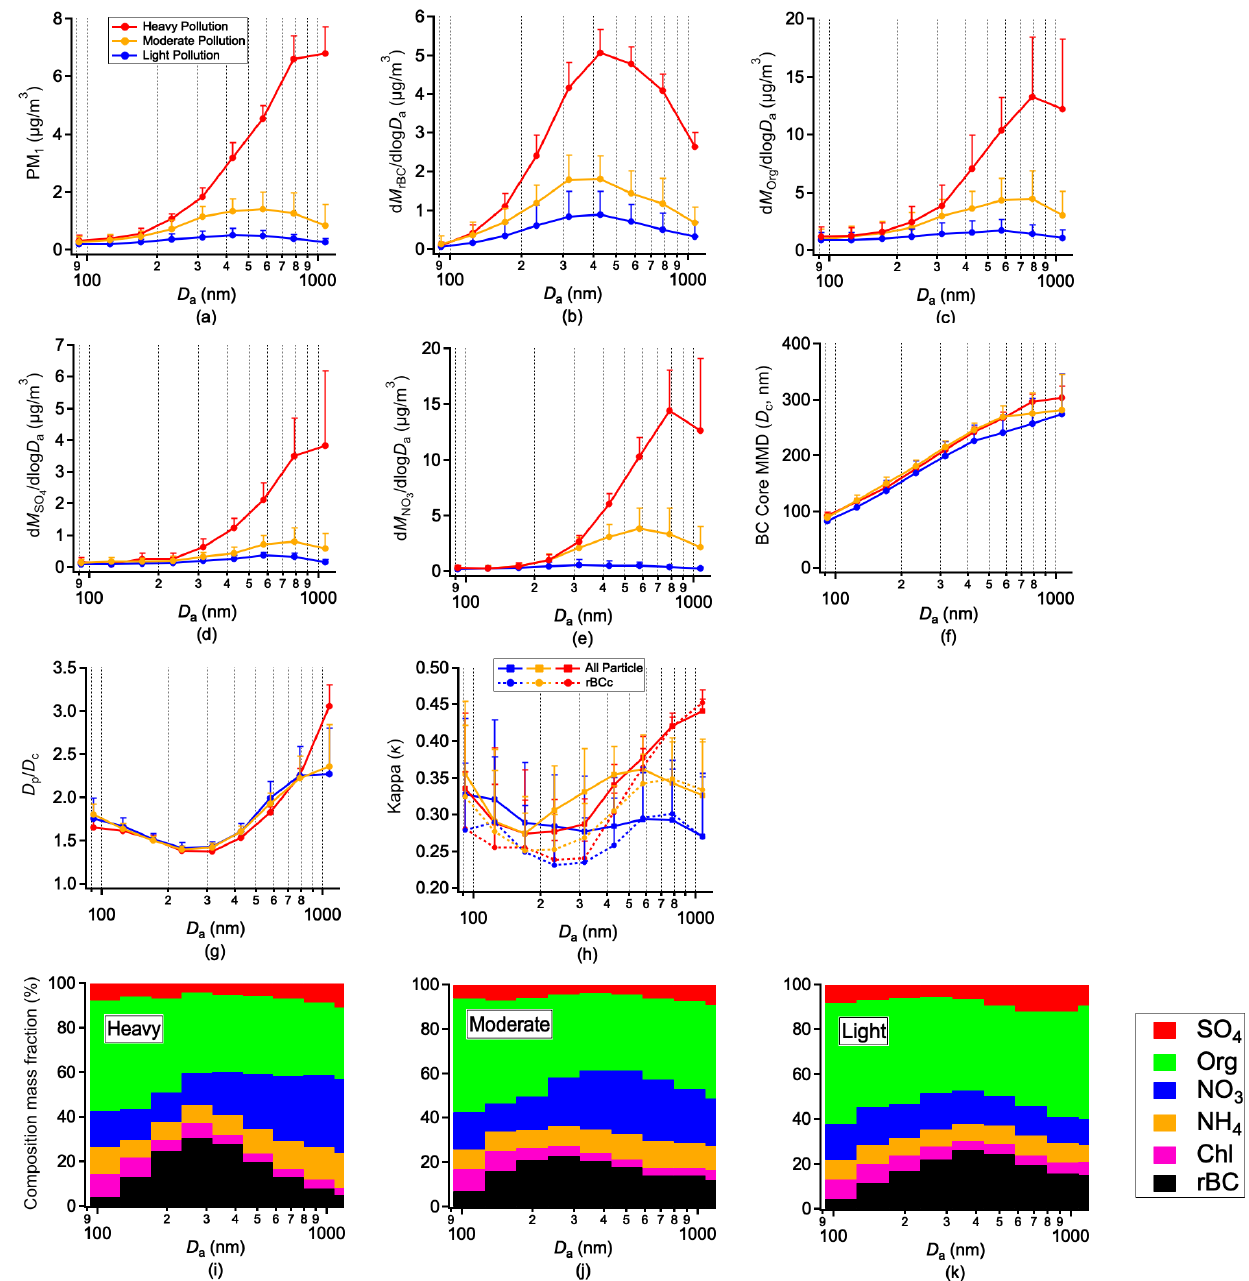
Figure 5. Size-resolved (a) PM 1 (mean ± standard deviation), (b) rBC mass concentration, (c) Org mass concentration, (d) SO 4 mass concentration, (e) NO 3 mass concentration, (f) size-resolved rBC core mass median diameter (MMD), (g) size-resolved coating thickness ( D p /D c ) of rBCc, (h) hygroscopicity parameter ( κ ) and (i–k) aerosol composition mass fractions under three different pollution